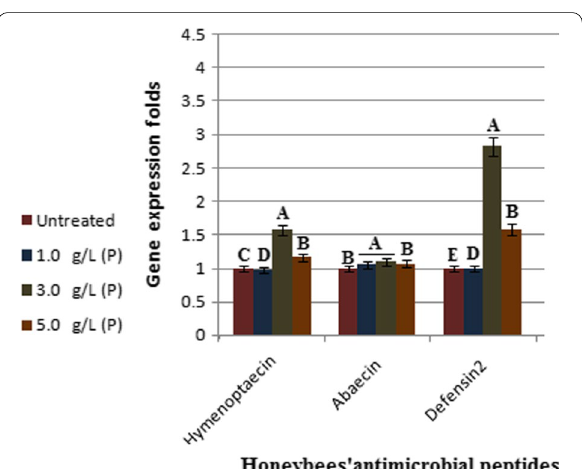
Fig. 3 The effect of Egyptian propolis ethanolic extract (EP) in different concentrations on the expression folds of antimicrobial peptides for honeybee with SE performed in ±